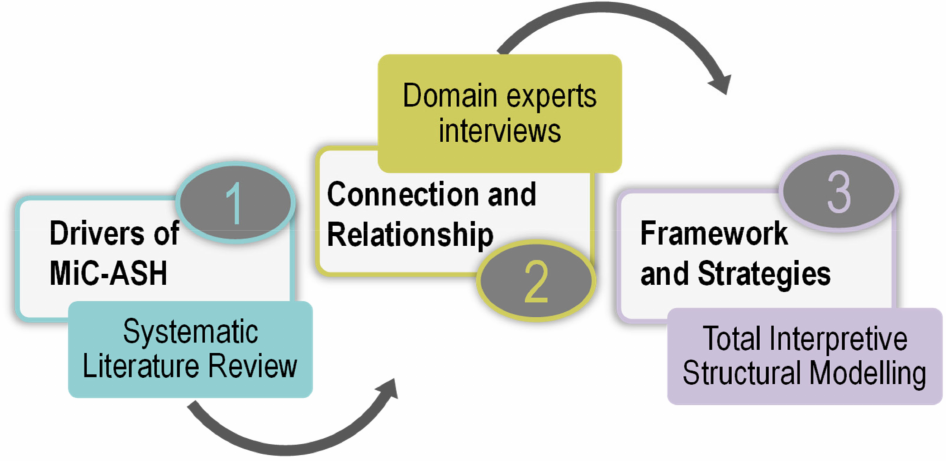
Figure 3. Three-way methodology of the proposed